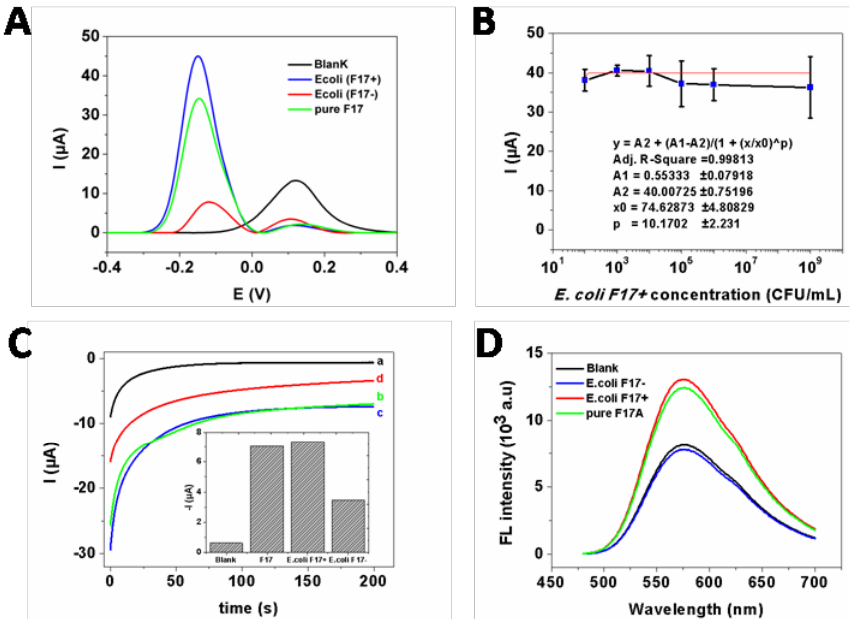
Figure 5. ( A ) DPV responses of the sandwich electrochemical immunosensor in the absence (a) and presence of E. coli F17 −positive (10 6 CFU·mL −1 ) (b); E. coli F17 − negative (10 6 CFU·mL −1 ) (c) and pure F17A protein (1.5 mg·mL −1 ) (d). ( B ) The calibration plot of E. coli F17 – positive DPV detection where the data was fitted using 4-PL regression analysis. Error bars, SD, n = 3. ( C ) Amperometric responses of the sandwich electrochemical immunosensor: (a) in the absence of any analyte (blank) and in the presence of (b) pure F17A protein (1.5 mg·mL −1 ); (c) E. coli F17 −positive (10 6 CFU·mL −1 ); and (d) E. coli F17 −negative (10 6 CFU·mL −1 ). ( D ) Fluorescence emission spectra ( λ ex /( λ em : 450/550 nm) of the sandwich immunosensor for the blank (black), in the presence of: 10 6 CFU·mL −1 of E. coli F17 −negative (blue); 10 6 CFU·mL −1 E. coli F17 −positive (ref) and pure F17A protein (1.5 mg·mL −1 ).